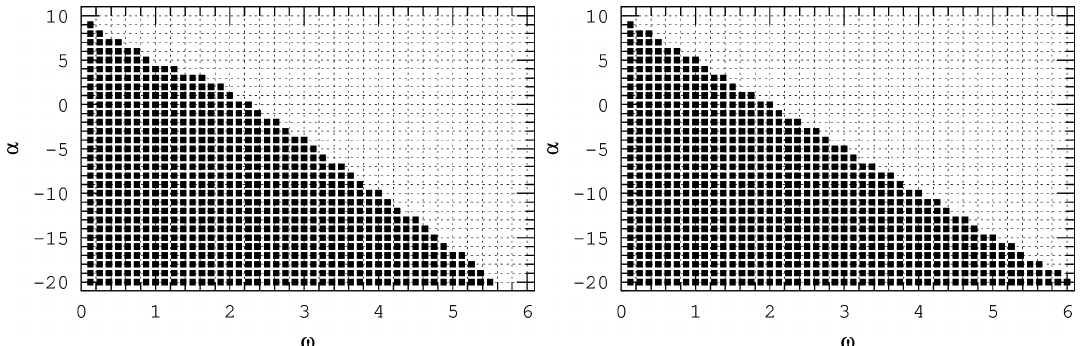
Fig. 5. Pairs .˛;!/ for which SOR-like converged. Fig. 6. Pairs .˛;!/ for which lSOR-like converged.